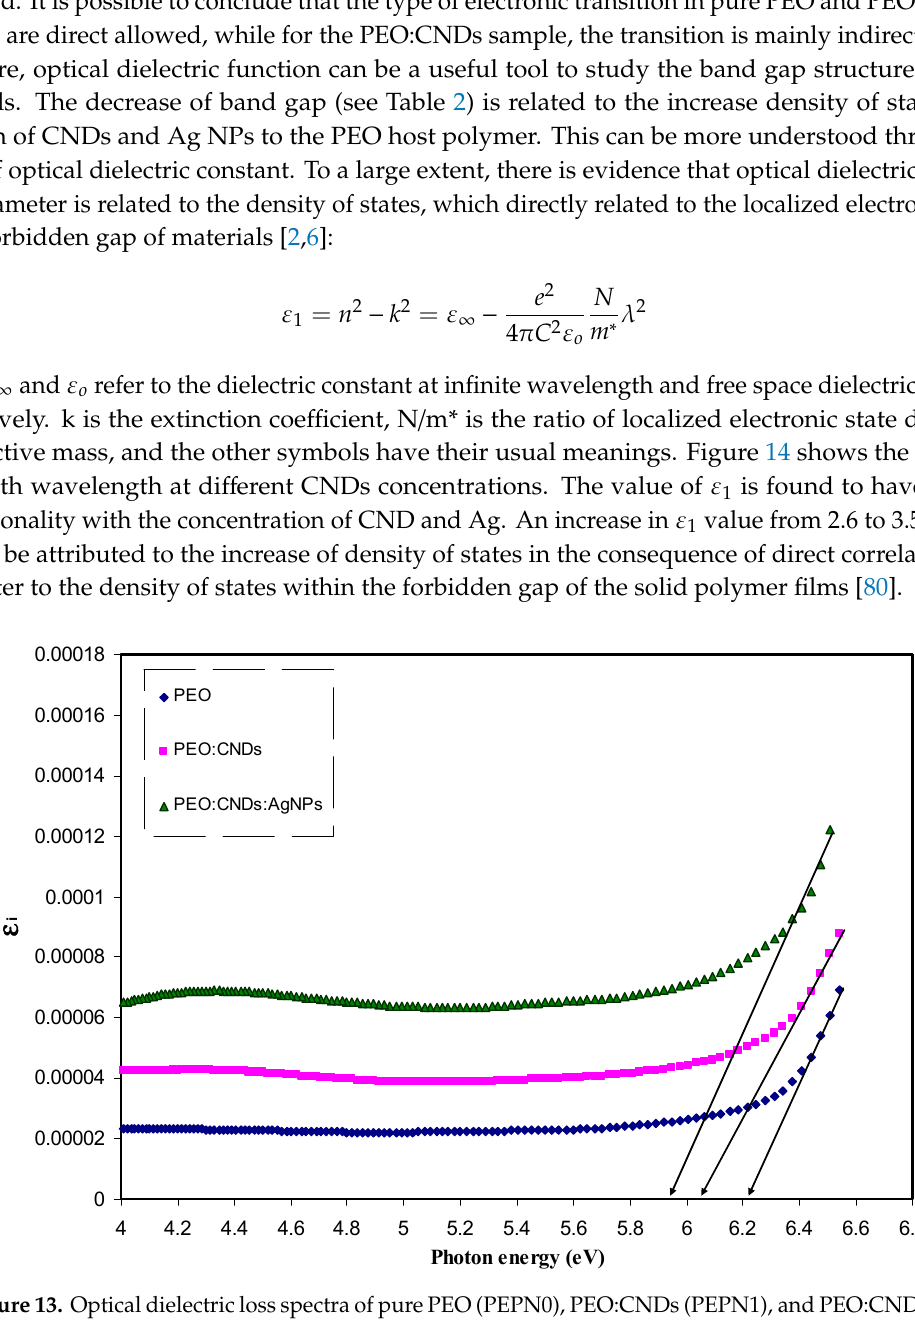
Figure 13. Optical dielectric loss spectra of pure PEO (PEPN0), PEO:CNDs (PEPN1), and PEO:CNDs:Ag (PEPN2) composite samples.